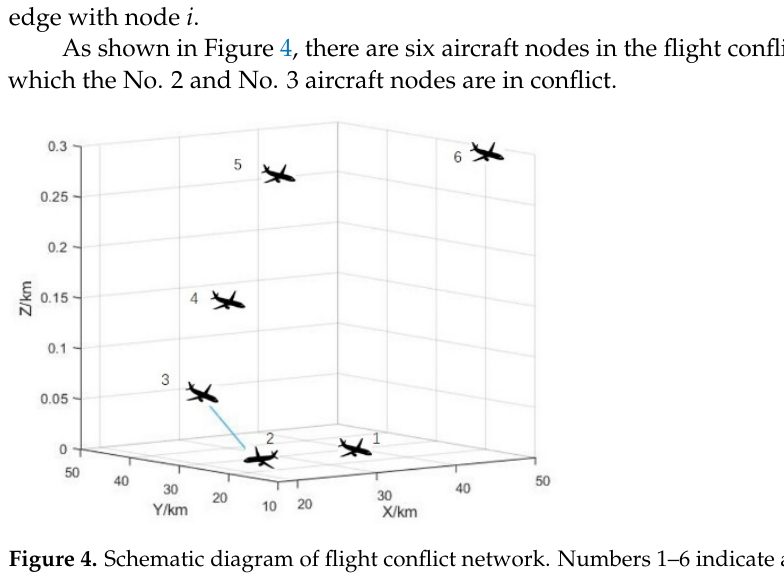
Figure 4. Schematic diagram of flight conflict network. Numbers 1–6 indicate aircraft designators.